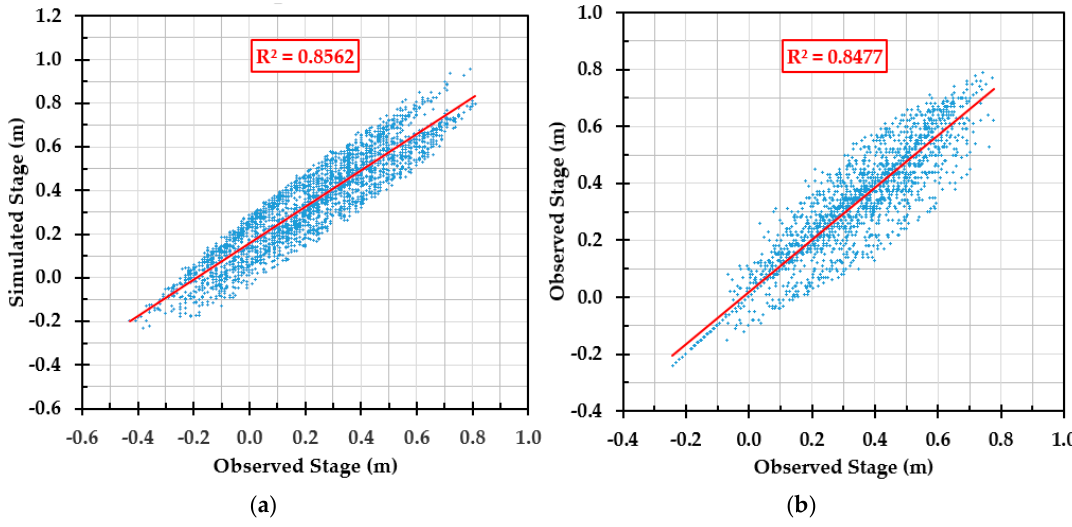
Figure 15. Model verification comparison between computed and observed stages for the chosen Manning’s values at ( a ) station number 3.2 and ( b ) station number 55.